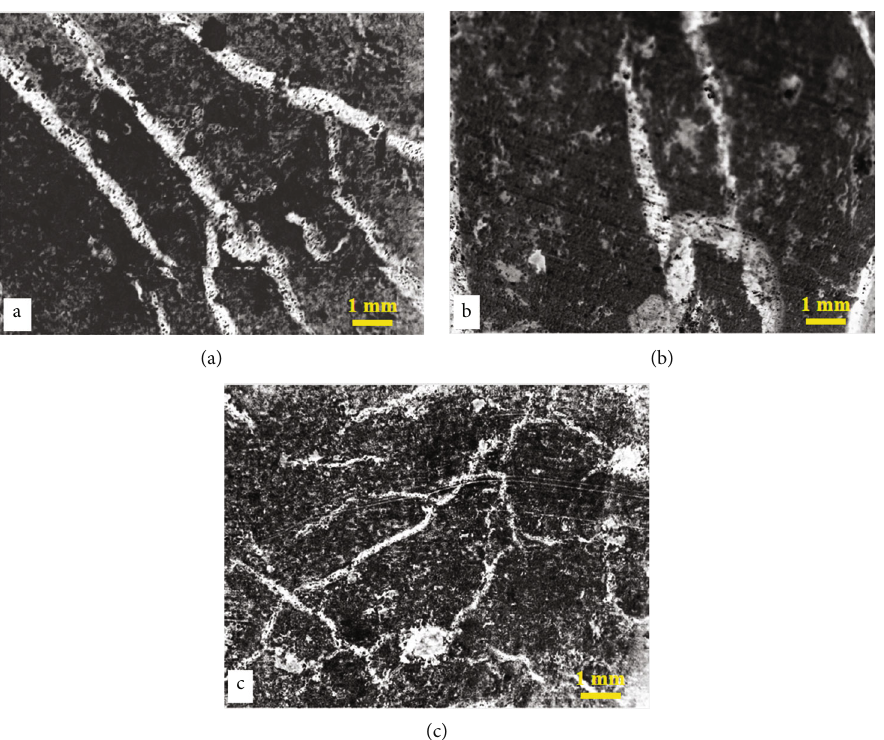
Figure 10: Macrocryo-structure of frozen soils with di ff erent moisture contents of 37% (a), 27% (b), and 20% (c) surrounding a pile at a given temperature of -5 °